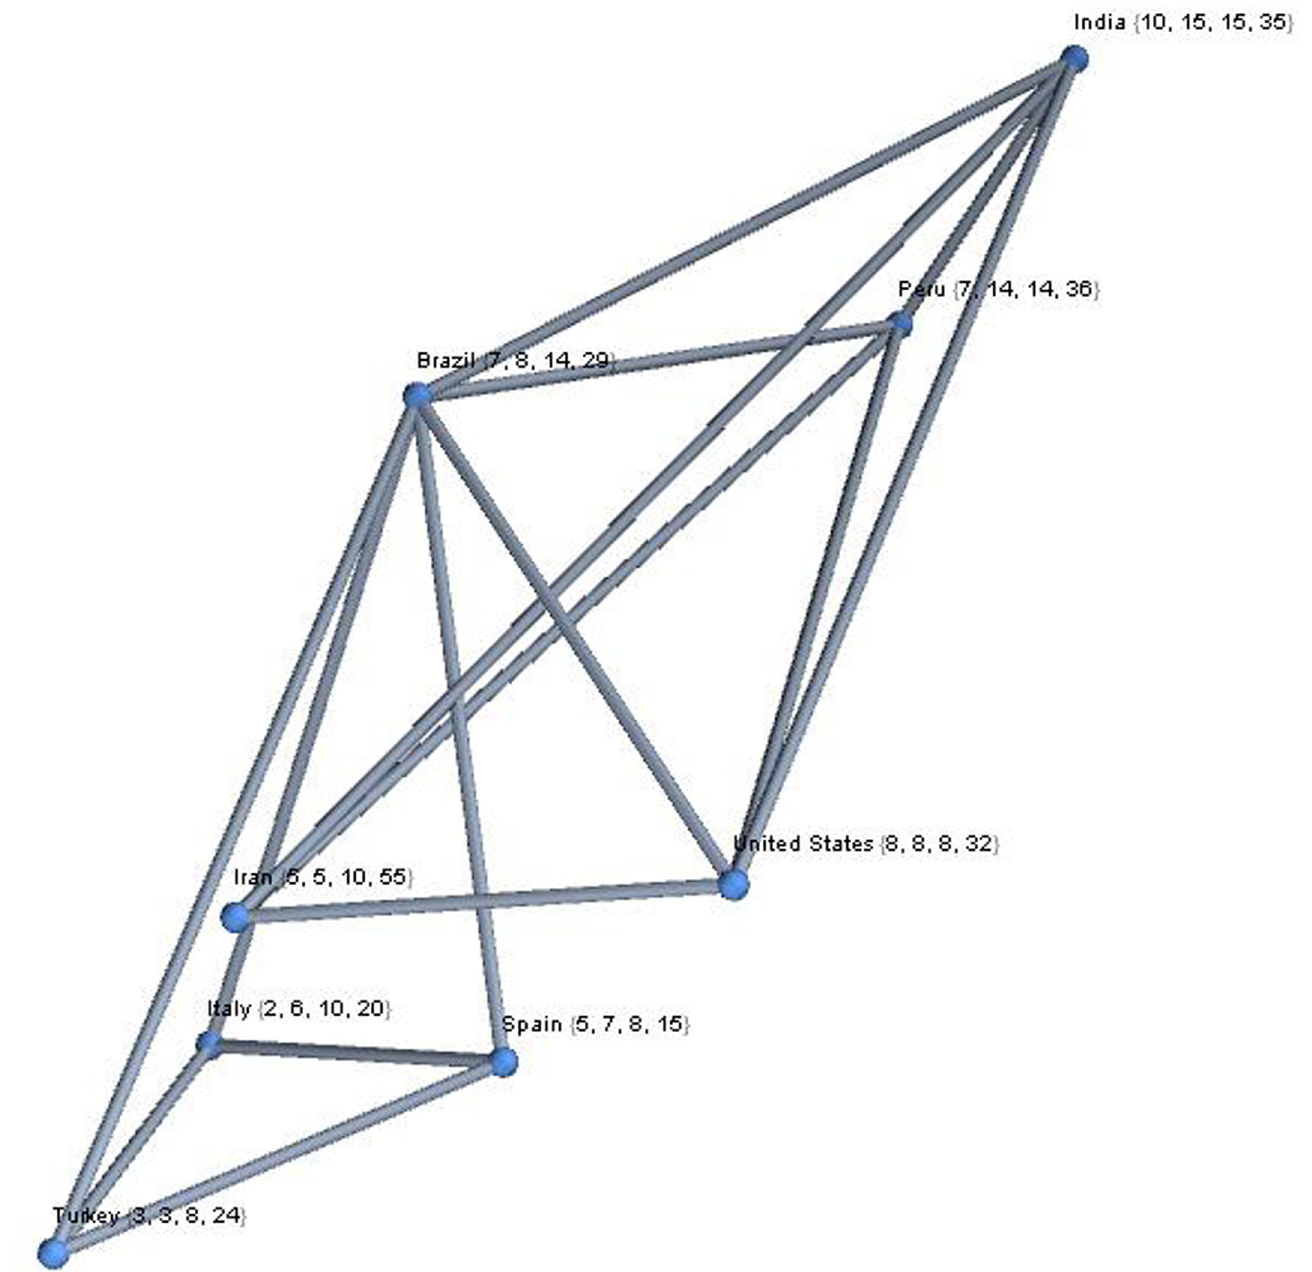
Fig 10. Complex graph representation of the eight countries, with four temporal intervals. This representation allows the highlighting of temporal relationships on the pandemic evolution between countries, by using complex networks statistics. refer to estimated cases of novel coronavirus (COVID-19, formerly known as 2019-nCoV) infection by country or region. “Data is based on WHO, U.S. CDC, ECDC, China CDC (CCDC), NHC and DXY. Data for Hong Kong SAR, Macau SAR, and Taiwan have been downloaded from [35]. Data have been cleaned and aggregated by regions and countries, then harmonised by removing insecure data that did not correspond to international standard.217